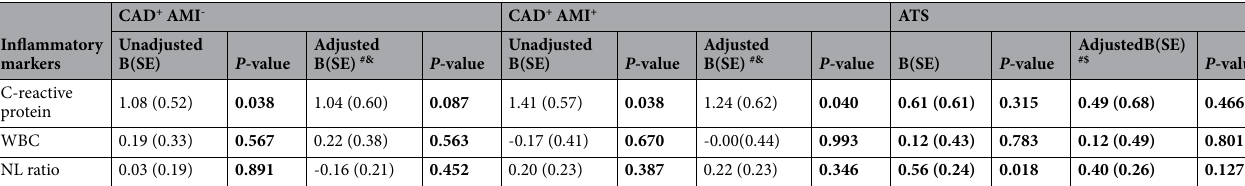
Table 3. Association of CAD and acute myocardial infarction (AMI) with inflammatory parameters. ATS: Atherothrombotic stroke, CAD + AMI + : Coronary artery disease with history of Acute myocardial infarction; CAD + AMI-: Coronary artery disease without history of Acute myocardial infarction, B: Regression co-efficient, SE: Standard error. # Adjusted for age, gender, body mass index (BMI), diabetes mellitus (DM), hypertension (HTN), cancer, chronic kidney disease (stage 3–5), asthma, chronic obstructive pulmonary disease (COPD), liver cirrhosis, transplant status, baseline sputum AFB status, cavitary disease at baseline, metformin use, statin use, and calcium channel blocker use. & Additionally adjusted for ATS. $ Additionally adjusted for